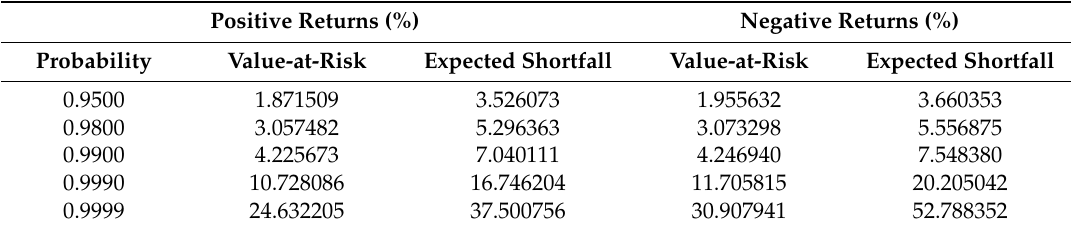
Table 11. VaR and expected shortfall ( ES ) (conditional value-at-risk ( CVaR )) of the GSE